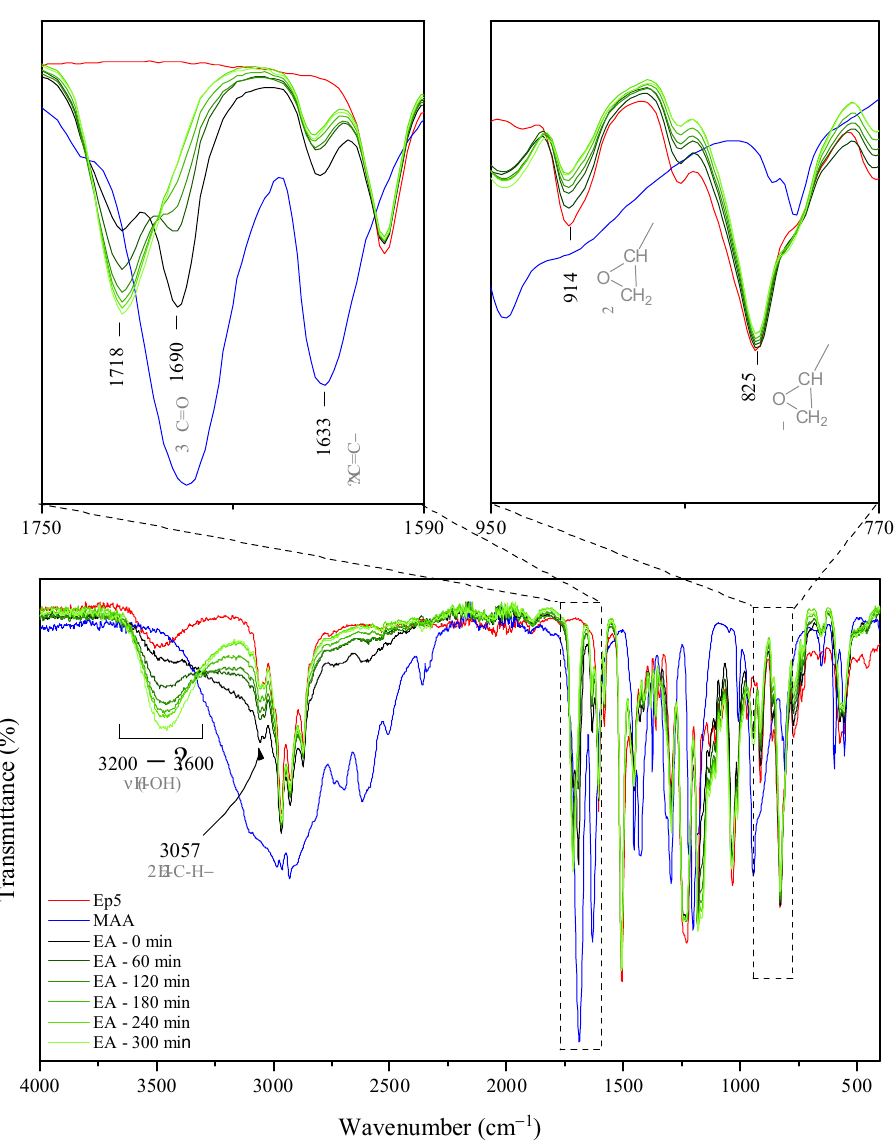
Figure 1. FT-IR spectra of epoxy resin, methacrylic acid, and EA prepolymers collected throughout the reaction time (the digit at the end of sample code indicates the reaction time; “0” stands for reaction mixture preheated to 70 °C). Reported spectra were recorded at room temperature, as an average of sixteen scans.